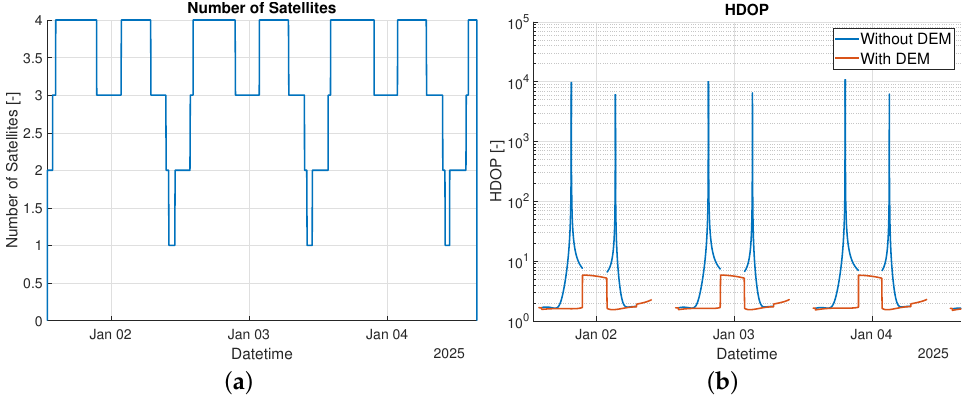
Figure 10. Geometry of the scenario. ( a ) shows the number of visible satellites in time, while ( b ) shows the HDOP considering both the LCNS-only and LCNS + DEM